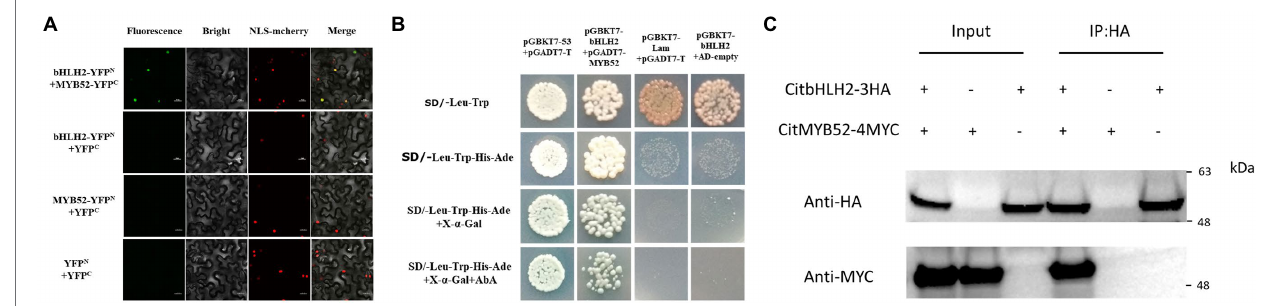
FIGURE 5 | Protein–protein interaction between CitMYB52 and CitbHLH2. (A) In vivo interaction between CitMYB52 and CitbHLH2, determined using BiFC. N- and C-terminal fragments of YFP (indicated on the figure as YFPN and YFPC) were fused to the C terminus of CitbHLH2 and CitMYB52, respectively. The pairs of